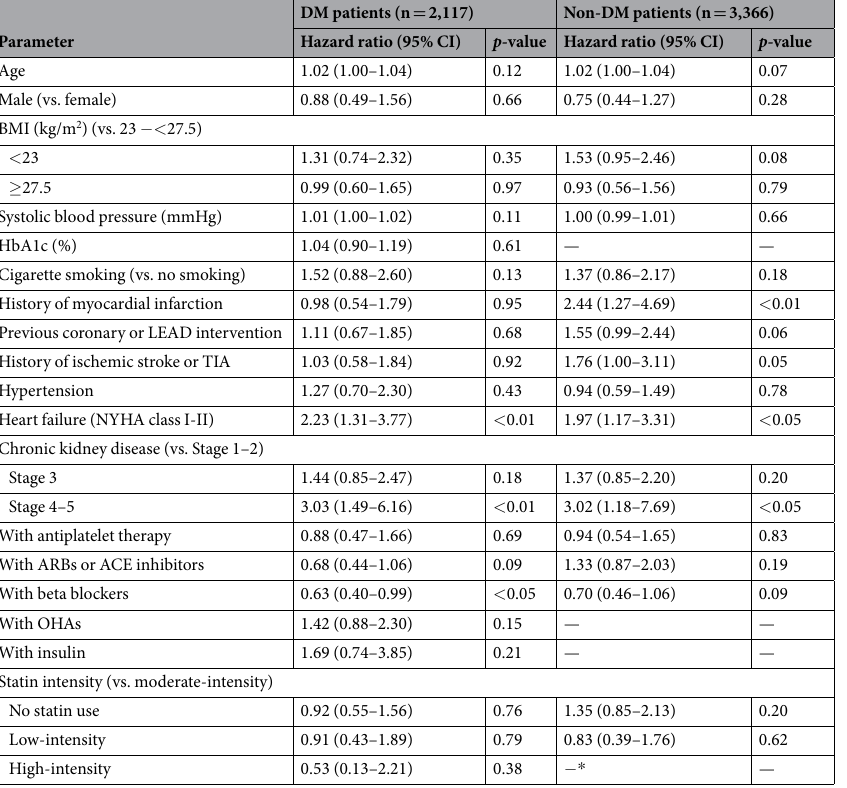
− * — Table 3. Multivariable Cox proportional hazards model for predicting MACE in diabetic and nondiabetic ASCVD patients (Model for LDL-C). * The hazard ratio could not be estimated because no event occurred in the 107 non-DM patients taking high-intensity statin therapy. † These multivariable models included LDL-C levels and all the variables listed in this table. The adjusted hazard ratios for the association between LDL-C levels and recurrent MACE are listed in Table 4. ACE = angiotensin-converting enzyme; ARB = angiotensin II receptor blocker; LEAD = lower extremity arterial disease; NYHA = New York Heart Association; OHA = oral hypoglycemic agent; TIA = transient ischemic